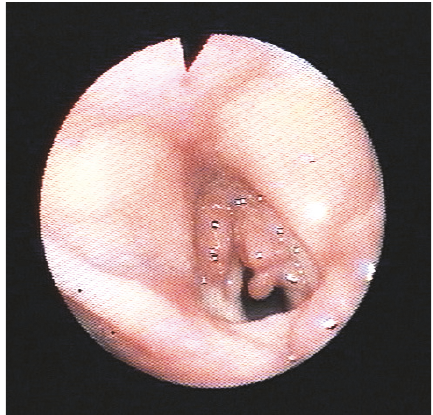
Figure 3: Indirect laryngoscopy on ward one week following debridement showing reproliferation of granulation tissue from both vocal cord and airway